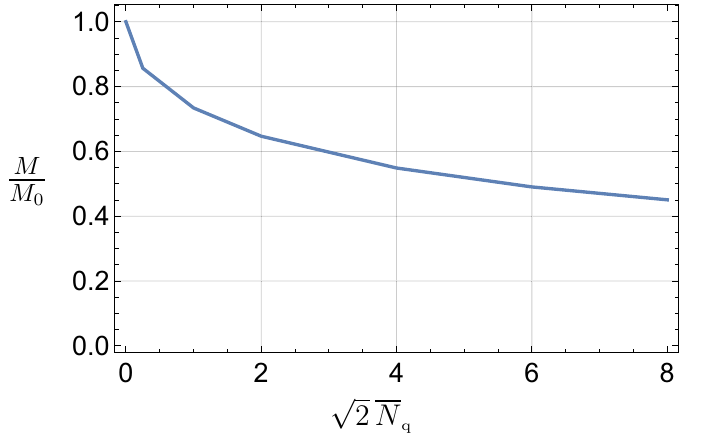
defined through eqs. (5.11) and (5.13), respectively. (cid:31)